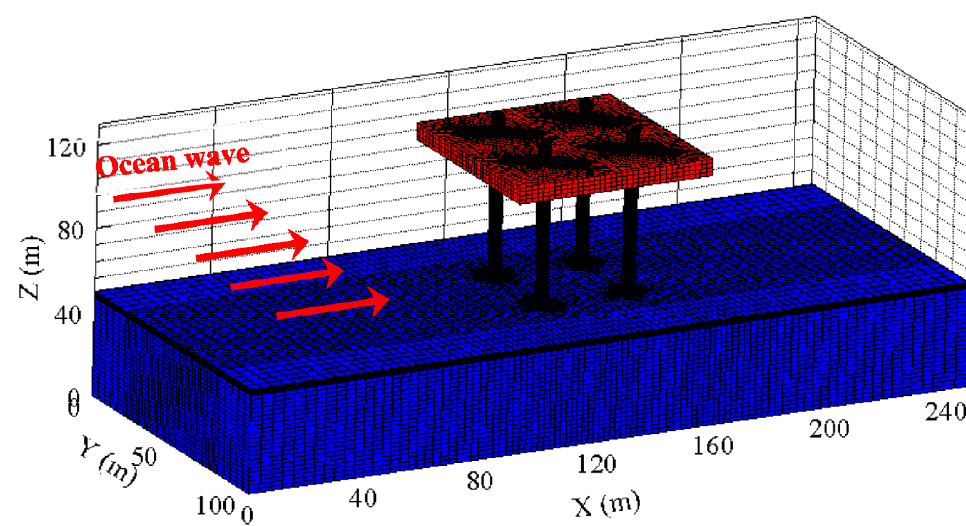
Figure 3. Generated mesh for the offshore jack-up platform and its seabed foundation (noted: the four pile legs are thin-walled and hollow).